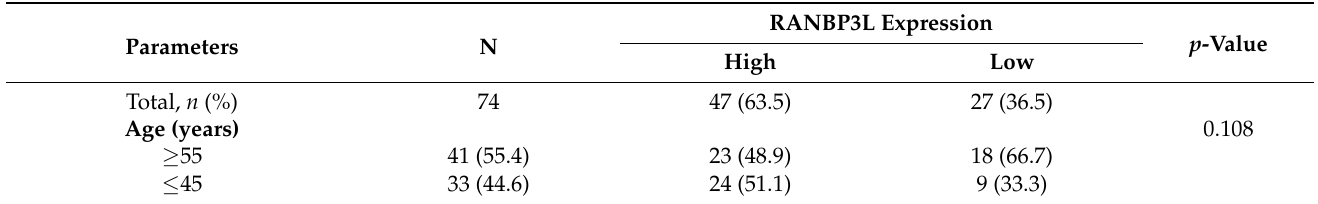
Figure 5. RANBP3L expression in normal breast duct, ductal carcinoma in situ, and invasive breast carcinoma tissues. RANBP3L expression in ( A , B ) normal breast duct tissues, ( C , D ) ductal carcinoma in situ tissues, and ( E , F ) invasive breast carcinoma tissues; ( A , E , F ), × 50 µ m, ( B ), × 20 µ m, ( C , D ), × 100 µ m. Table 7. Association of RANBP3L expression with the clinicopathological features of breast cancer